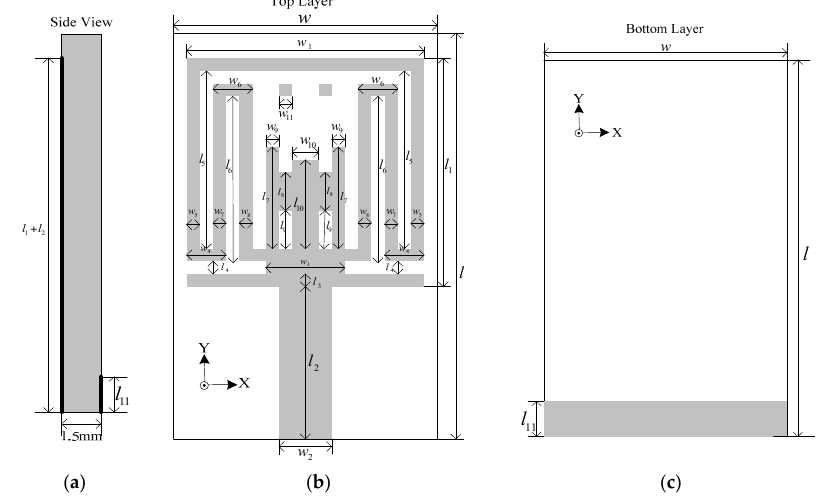
Figure 1. Geometry of the proposed antenna: ( a ) side view; ( b ) top view; ( c ) bottom view. Table 1. Optimal dimensions of the proposed antenna.